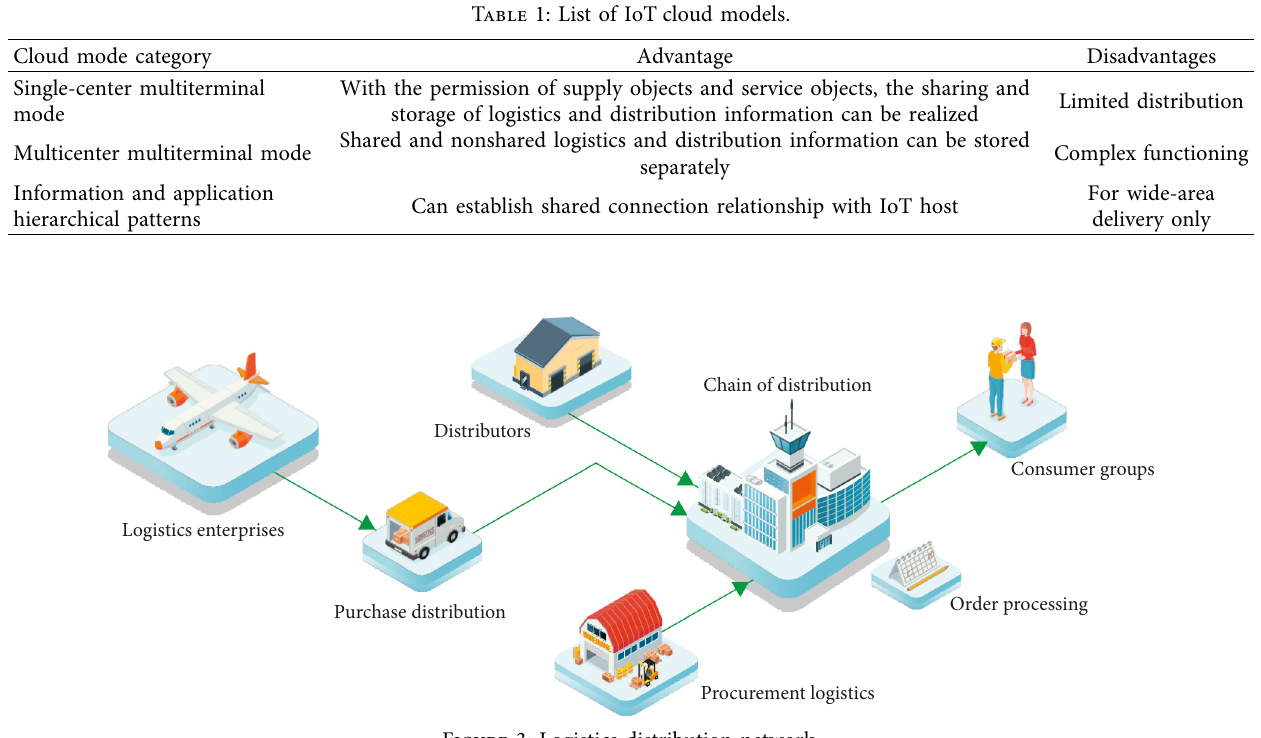
Figure 3: Logistics distribution